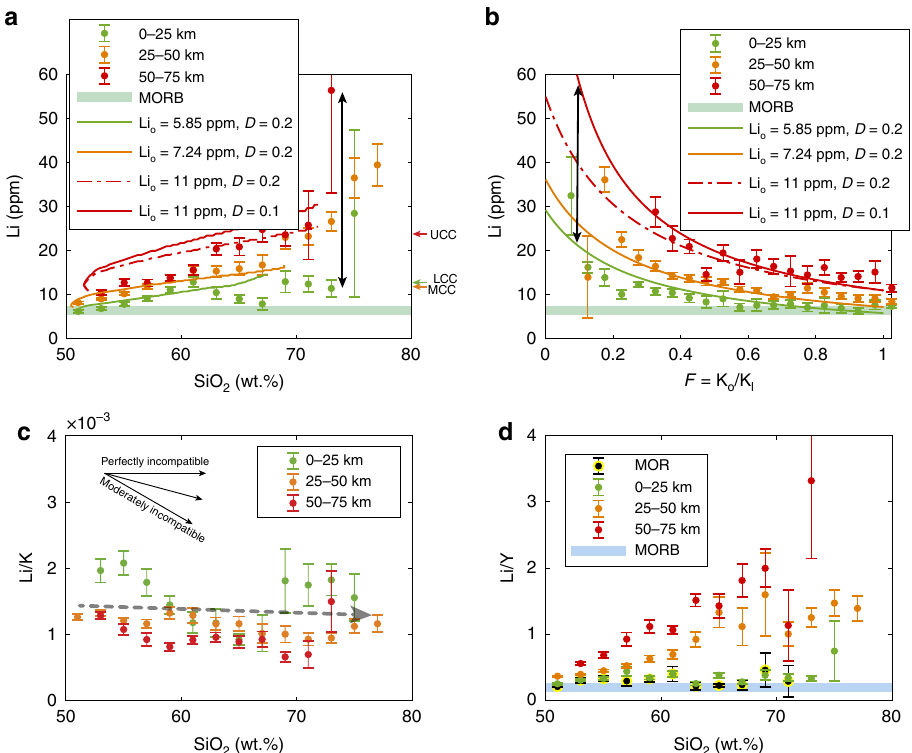
Fig. 2 Evolution of Li systematics in arc magmas for arcs of different crustal thicknesses. a Li (ppm) vs. SiO 2 . b Li (ppm) vs. residual melt fraction ( F ) as determined by the relative enrichment of K. c Li (ppm)/K (ppm) vs. SiO 2 . d Li (ppm)/Y (ppm) vs. SiO 2 . Arc magmas were divided into three crustal thickness groups (0 – 25 km, 25 – 50 km, and 50 – 75 km) based on calculated crustal thickness (see “ Methods “ ). For each crustal thickness interval, samples were averaged in intervals of 2 wt.% SiO 2 or 0.05 residual melt fraction. Error bars on Li, Li/K, and Li/Y represent two standard error (2se). In ( a ) and ( b ), solid and dotted lines show modeled residual melt compositions due to crystal fractionation for different initial Li content (Li o ) and bulk partition coef fi cient (D) (see “ Methods ” ). Pale green bar in ( a ) and ( b ) denotes average Li concentration of mid-ocean ridge basalt (MORB) from Gale et al. 22 . Pale blue bar in ( d ) shows the Li/Y ratio of MORB from Ryan and Langmuir 9 . The colored arrows in ( a ) show average Li contents of upper, middle, and lower continental crust from Rudnick and Gao 61 . Arc data are extracted from GEOROC 56 . Mid-ocean ridge data are from Keller et al. 62